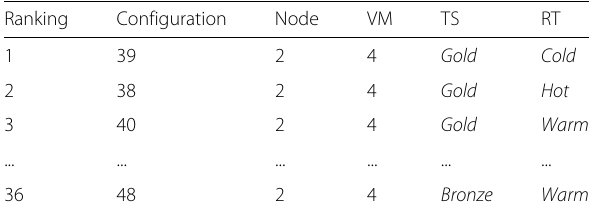
Table 13 Summary of the components used to rank